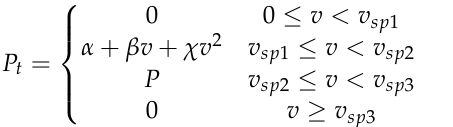
Figure 3. (a): Comparison of junction temperatures at an output frequency of 50 Hz ; (b): Compari- Figure 3. ( a ): Comparison of junction temperatures at an output frequency of 50 Hz; ( b ): Comparison son of junction temperatures at an output frequency of 5 Hz . of junction temperatures at an output frequency of 5